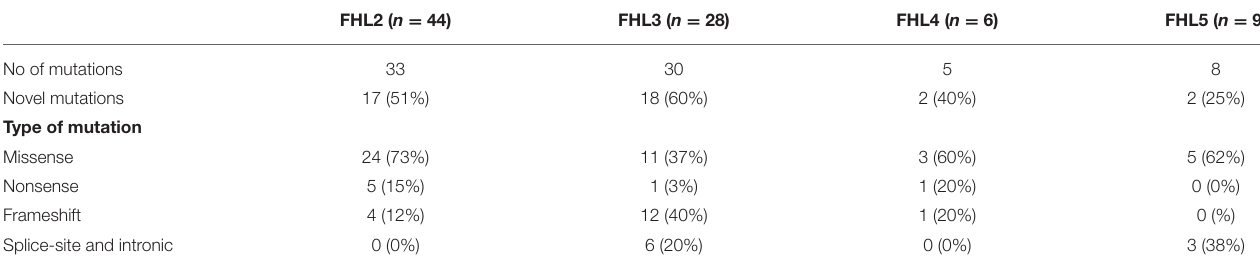
TABLE 2 | Different mutations identified in patients with